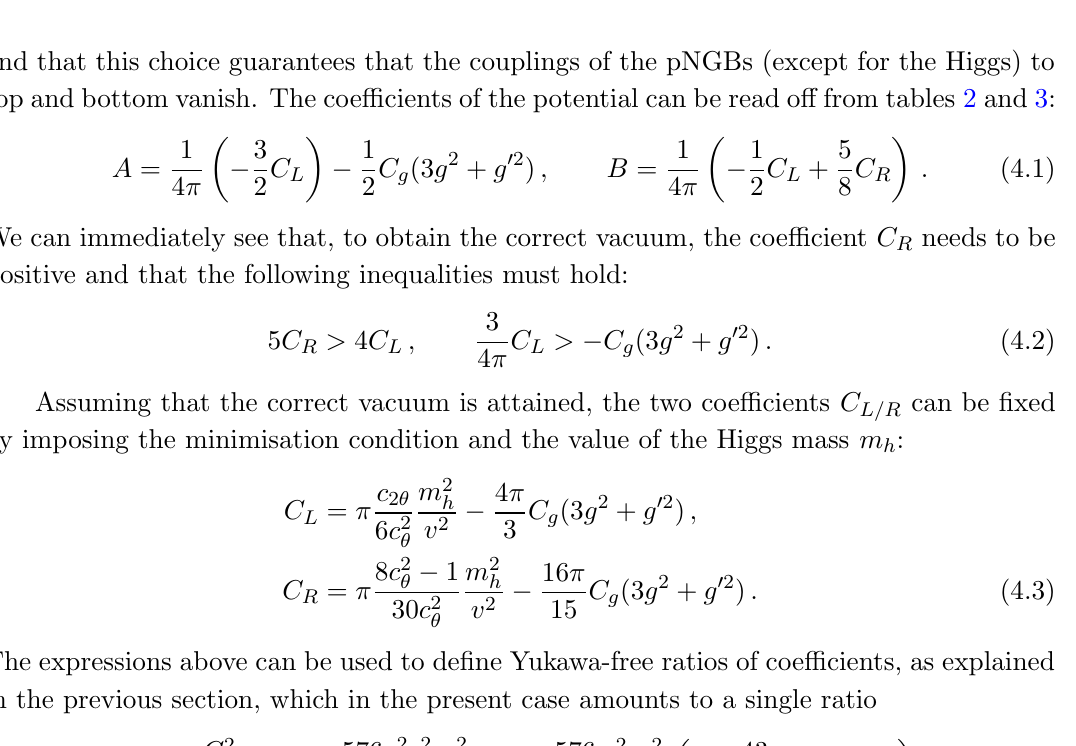
Figure 2 . Masses of the neutral (left) and charged (right) pNGBs in the case of the adjoint representation for (cid:18) = 0 : 1, as a function of the coe(cid:14)cient C g . A tachyonic state appears for C g & 0 : 023, almost aligned in the direction of the gauge singlet (cid:17)